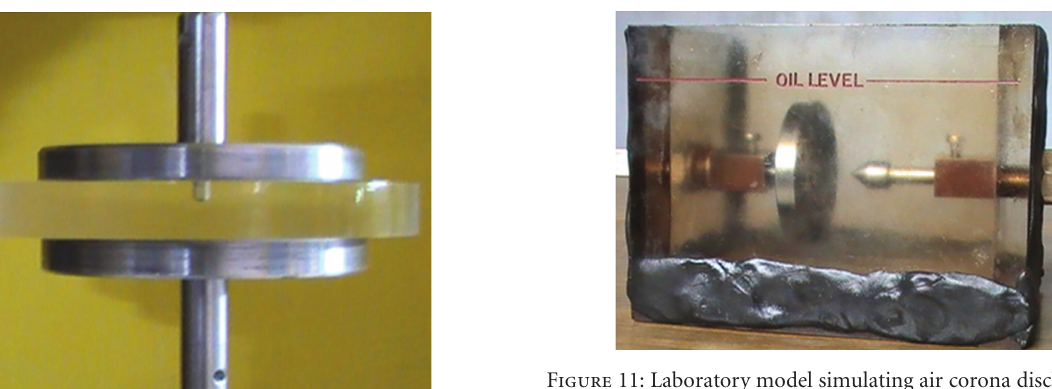
Figure 11: Laboratory model simulating air corona discharge with point configuration as high voltage electrode at an 85 ◦ apex angle.